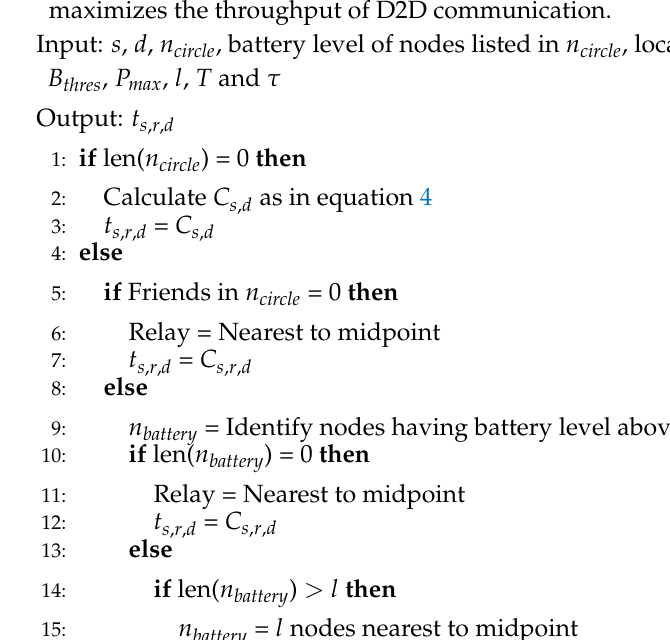
Algorithm 3: Tasks performed at Source for MRS-SD-BL // This algorithm consists of sequence of tasks performed by a node for midpoint relay selection using social distance and battery power. If a relay is to be used, it selects a relay that maximizes the throughput of D2D